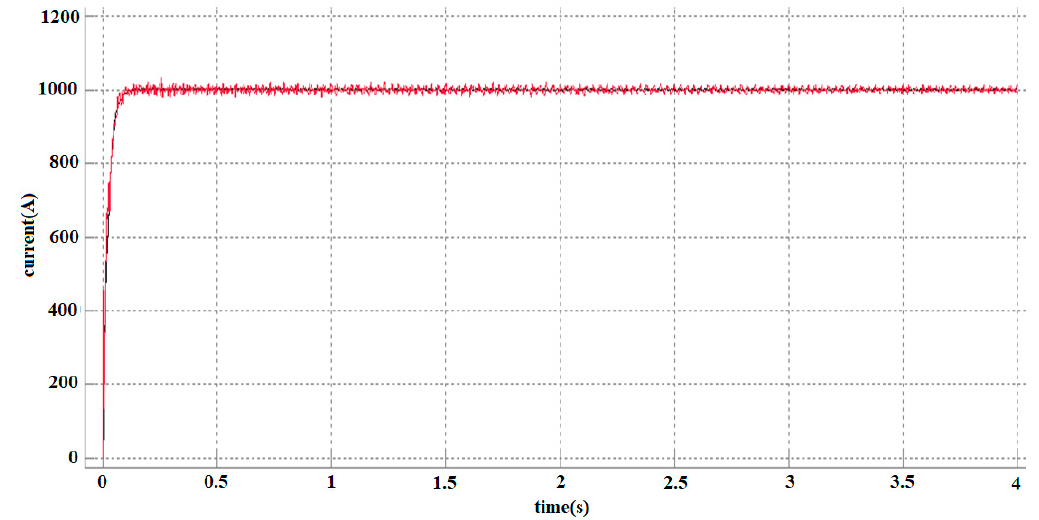
Figure 14. Hexverter active power tracking. The other thing that can be affected by the stability of the DC voltage levels within the hexverter is the voltage balancing technique, which could be beneficial in controlling the long-time run fluctuation.